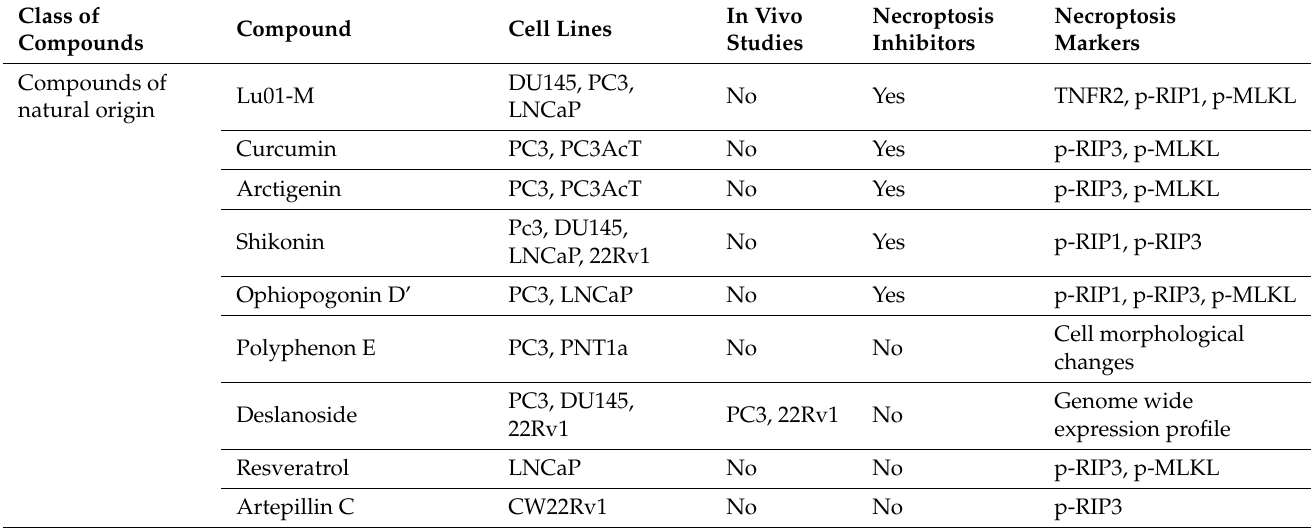
Figure 3. Chemical structures of synthetic and semisynthetic small molecules that induce necroptosis in prostate cancer cell lines. These compounds stimulate necroptosis by (i) inducing mitochondrial membrane permeability, (17E)- 5α -androst-3-en-17-one oxime and (17E)-androst-4-en-17-one oxime; (ii) inducing reactive oxygen species and cell-cycle arrest, 17-cyanopyridine pregnenolone; (iii) inducing cell growth inhibition following combination with necrostatin, HUHS1015; (iv) inhibiting Polo-like kinase 1, BI2536; (v) inhibiting kinases, sorafenib. Table 2. Compounds that induce necroptosis in prostate cancer cell